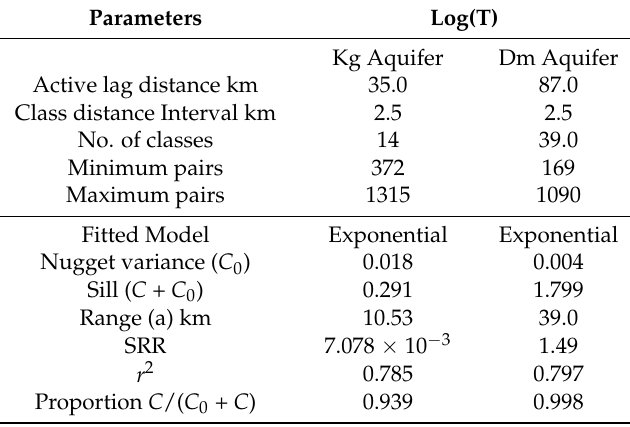
Table 2. Fitted parameters for model semivariogram.